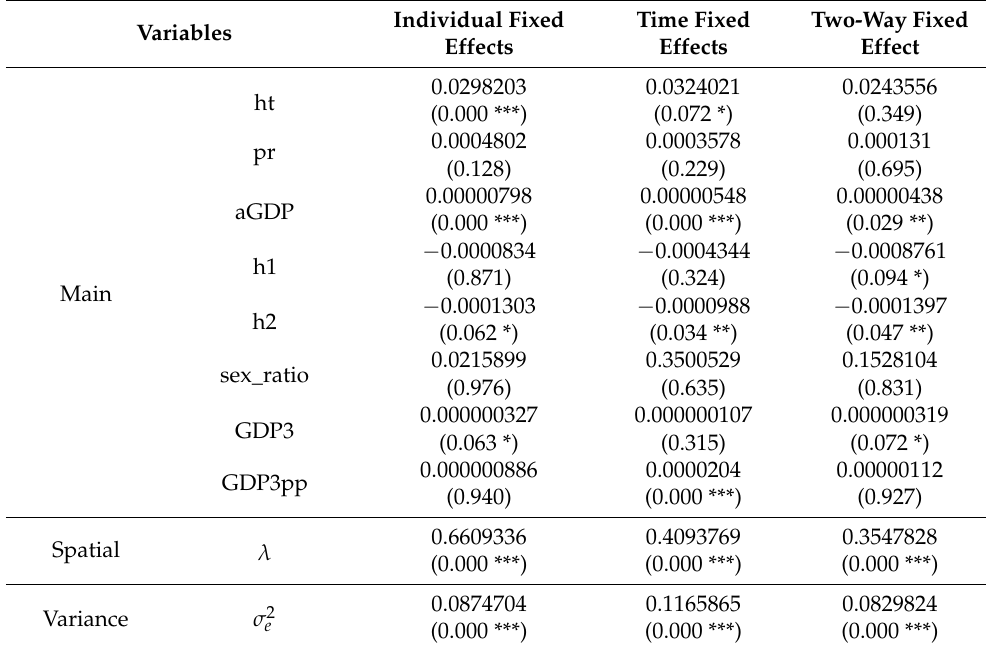
Table 6. The results of spatial error models with different kinds of fixed effects.